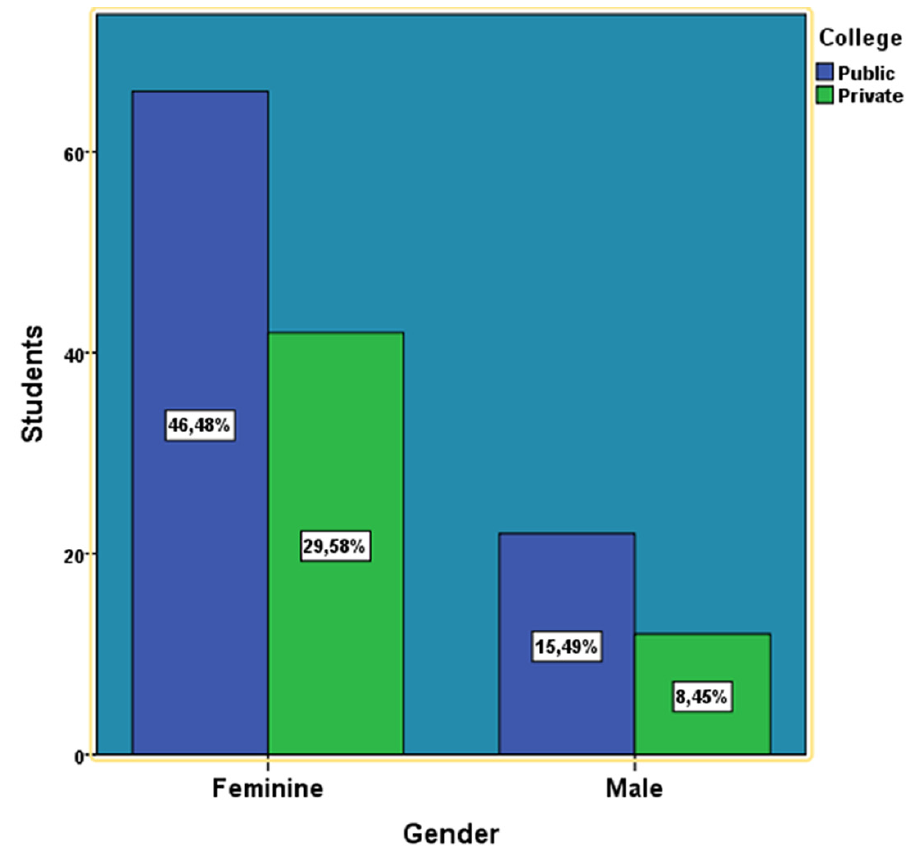
Fig. 2. Gender comparison by school